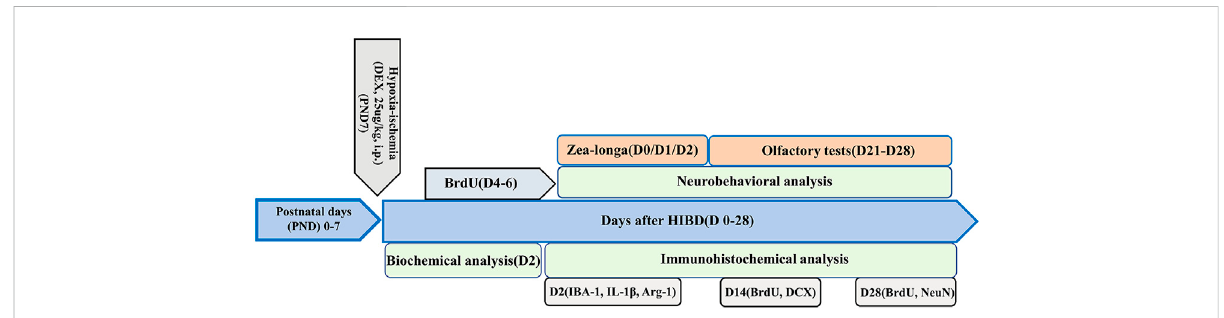
FIGURE 1 Flowchart of the experimental design deployed in the present study. Hypoxic-ischemic brain damage was induced in 7-day-old (PND 7) Sprague-Dawley rats. The rats were divided into three groups: a sham-operated group, a hypoxic-ischemic (HI) group and apost-HI DEX (25 μ g/kg, i.p.) interventiongroup (HI+ DEX). A proportion of theanimals inthese three groups underwentZea-Longa score analysis, biochemicalanalysis, and immuno fl uorescence analysis on day 2 after HI (D2). Some of the rats in these three groups were tested for neurogenesis